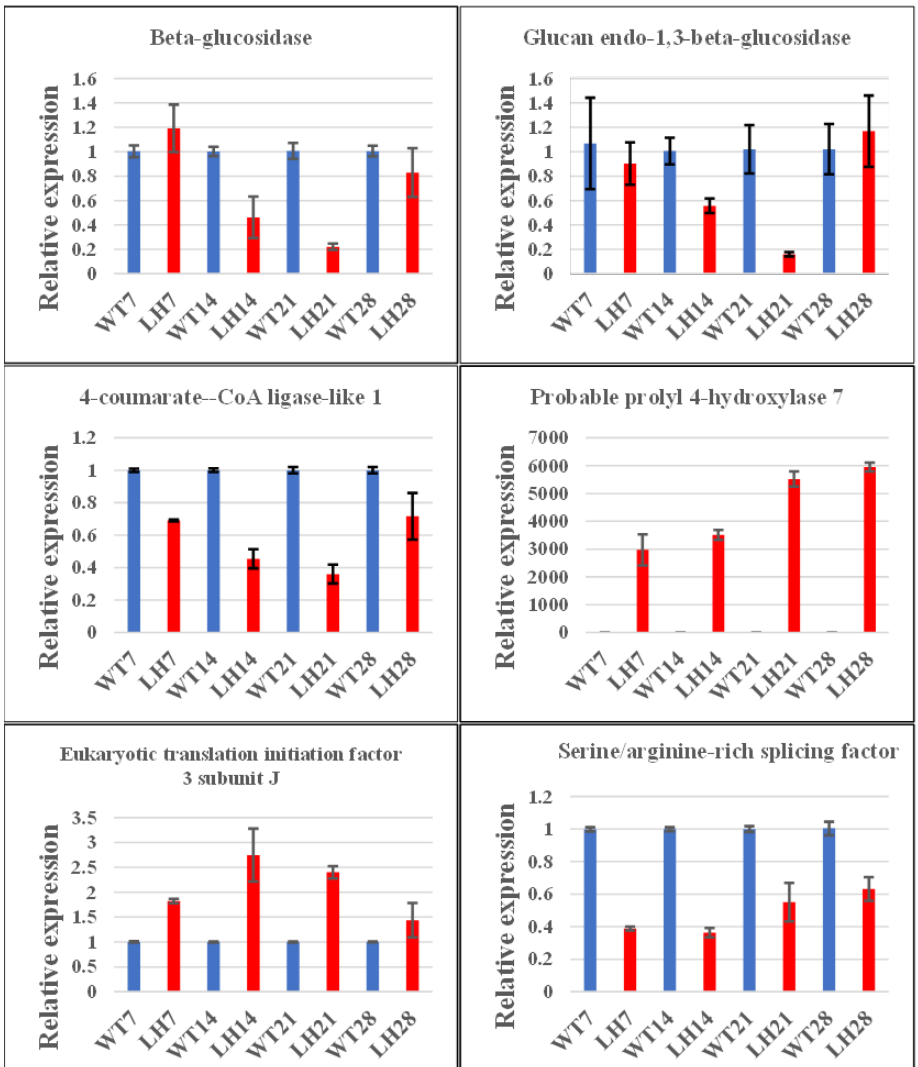
Figure 3. Relative expression of key genes at four seed developmental stages. Blue bar represents the wildtype (WT), red bar represents LH-11; expression level of WT was standardized at each stage to display a clear comparison with LH-11.